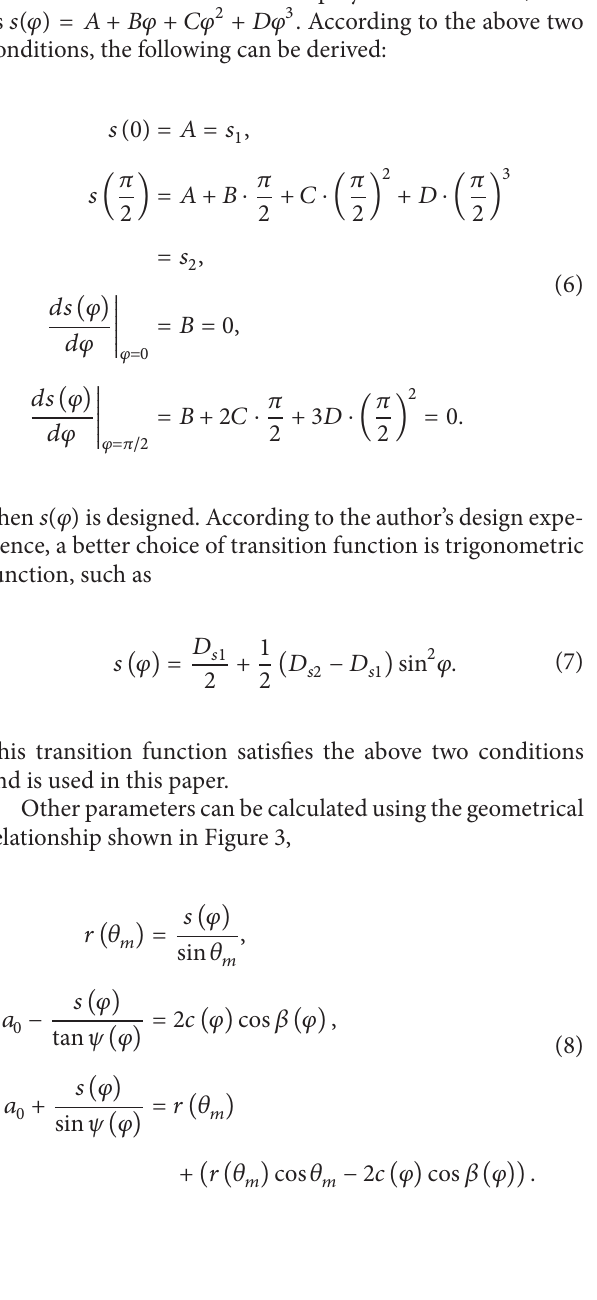
path, 𝐶 𝑘 , in 𝜑 = 90 ∘ plane can be written as (according to the reference plane 𝑥𝑜𝑦